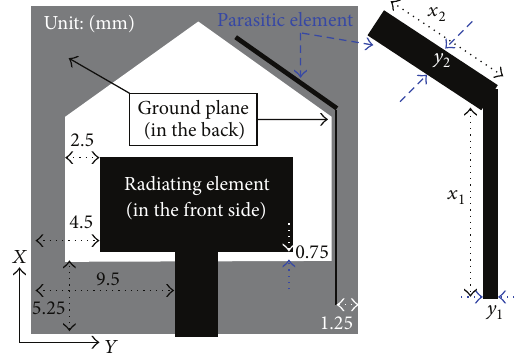
Figure 1: Geometry of the proposed antenna.